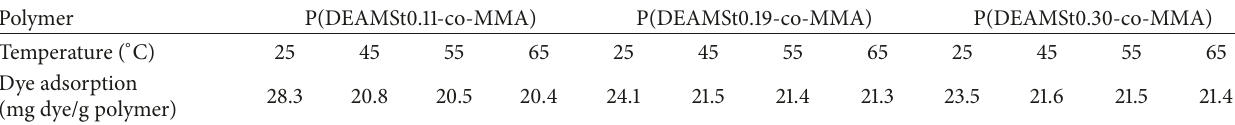
Table 3: The dye uptake amount of P(DEAMSt -co-MMA) in different temperatures.